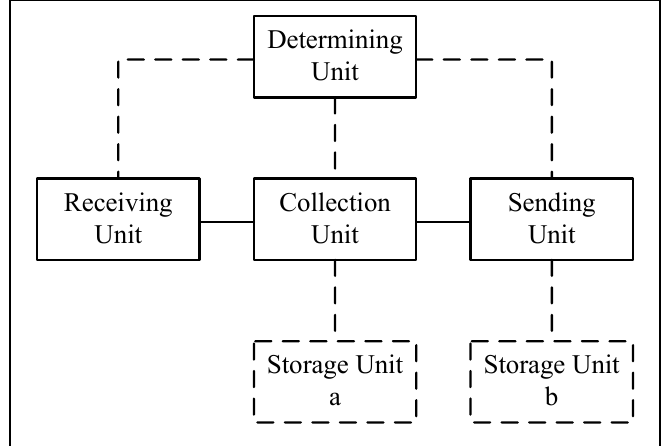
Figure 2. Vehicle device overall function